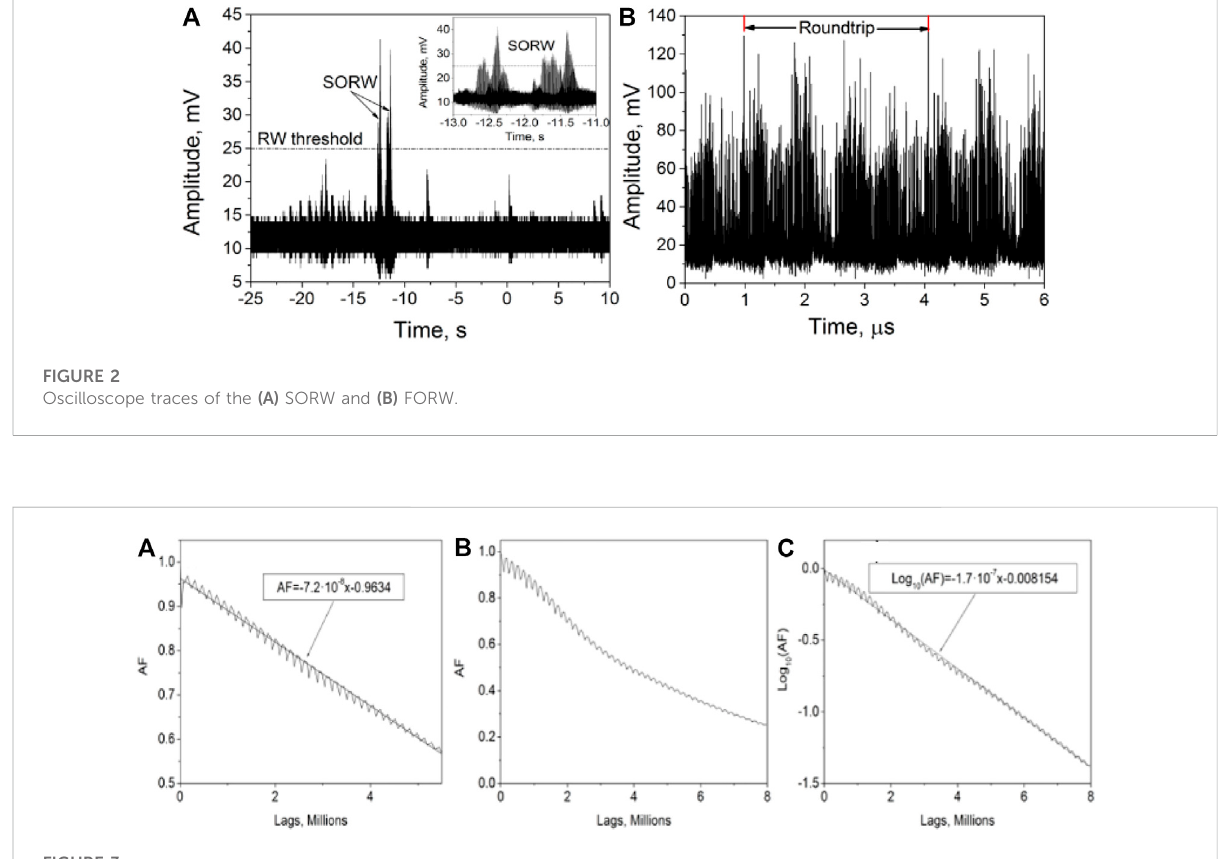
FIGURE 3 Autocorrelationfunctions; (A) theAFoftheSORWpattern, (B) theAFoftheobservedFORWpatterninthelinearscale,and (C) thelogscalewith linear fi tting. In all cases, the length of one lag was 0.1